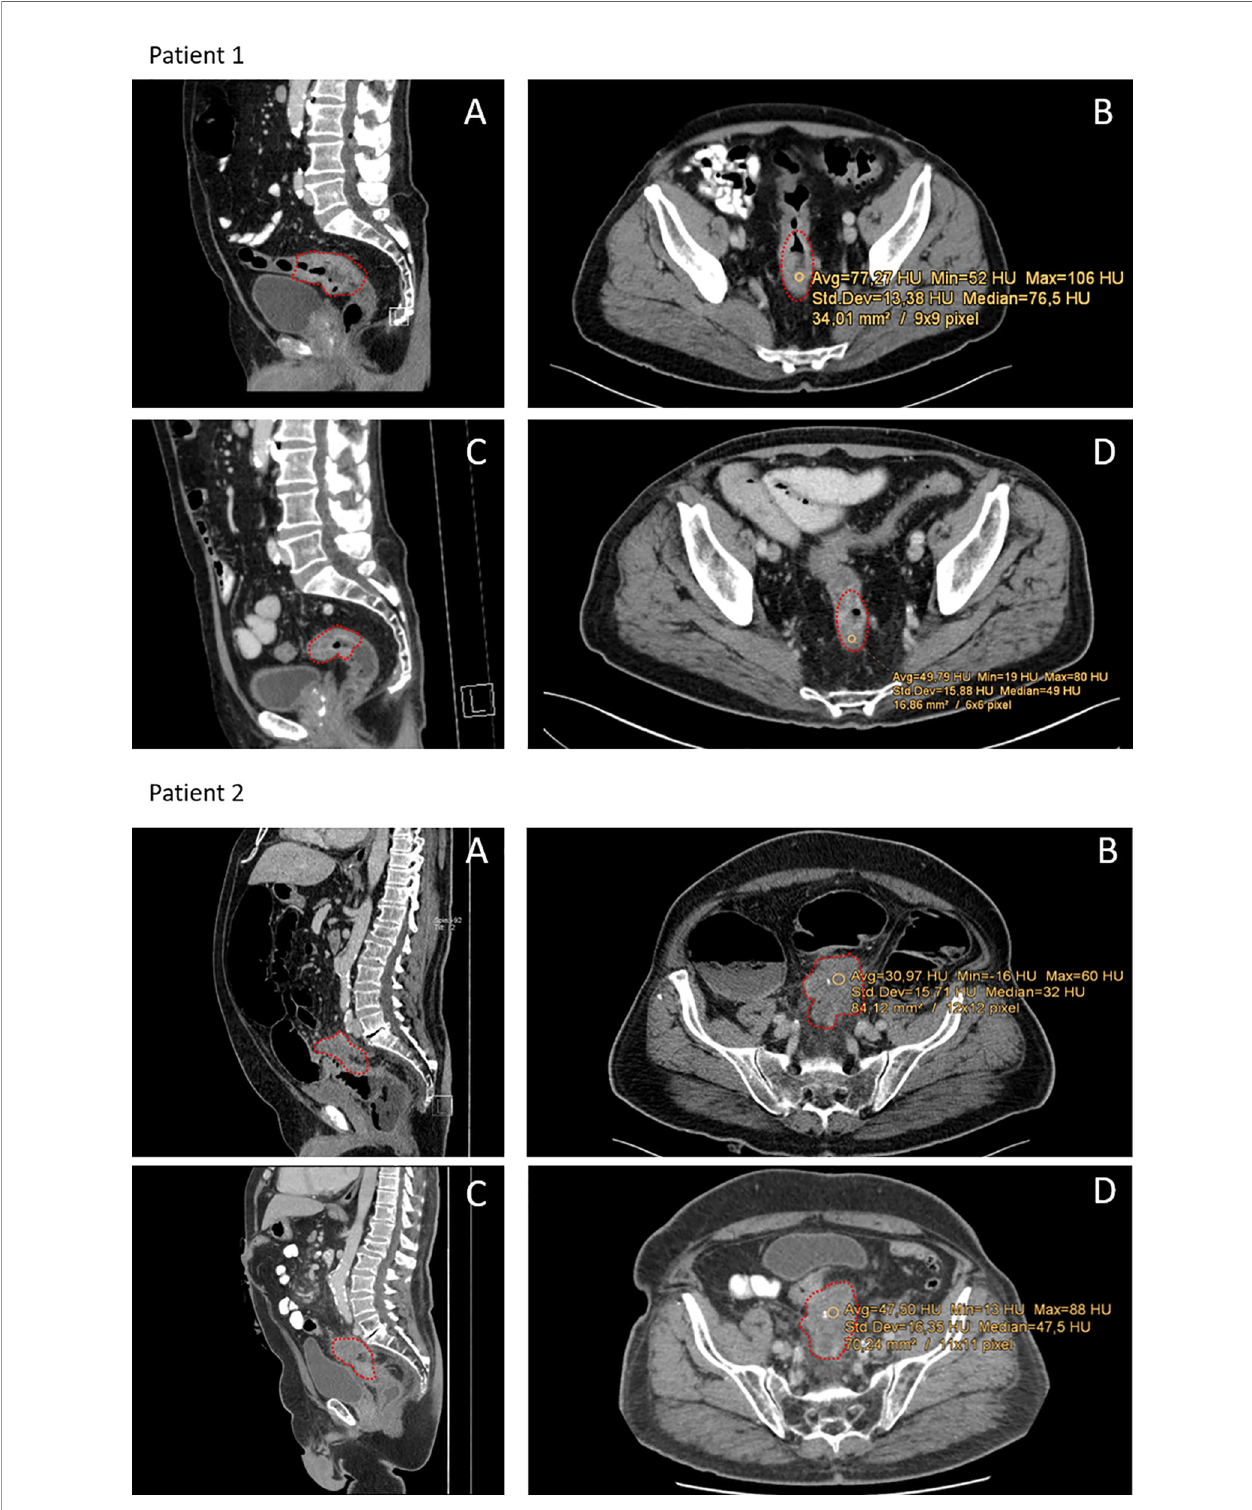
FIGURE 1 | Representative CT-scans of patients with different responses towards neoCRT. Red dots indicate the tumor region. Patient 1: Patient with complete pathological response (regression grade 4 according to Dworak). (A, B) Show pre-neoCRT CT-scans in sagittal and axial pro fi le. (C, D) Show CT-scans post- neoCRT. Median HU of the tumor was 76.5 HU pre- and 49 HU post-neoCRT. Patient 2: Patient with progressive disease and regression grade 1 according to Dworak and 80% viable tumor cells. (A, B) Show pre-neoCRT scans, (C, D) post-neoCRT CT-scans. Median HU increase from 31 to 48.